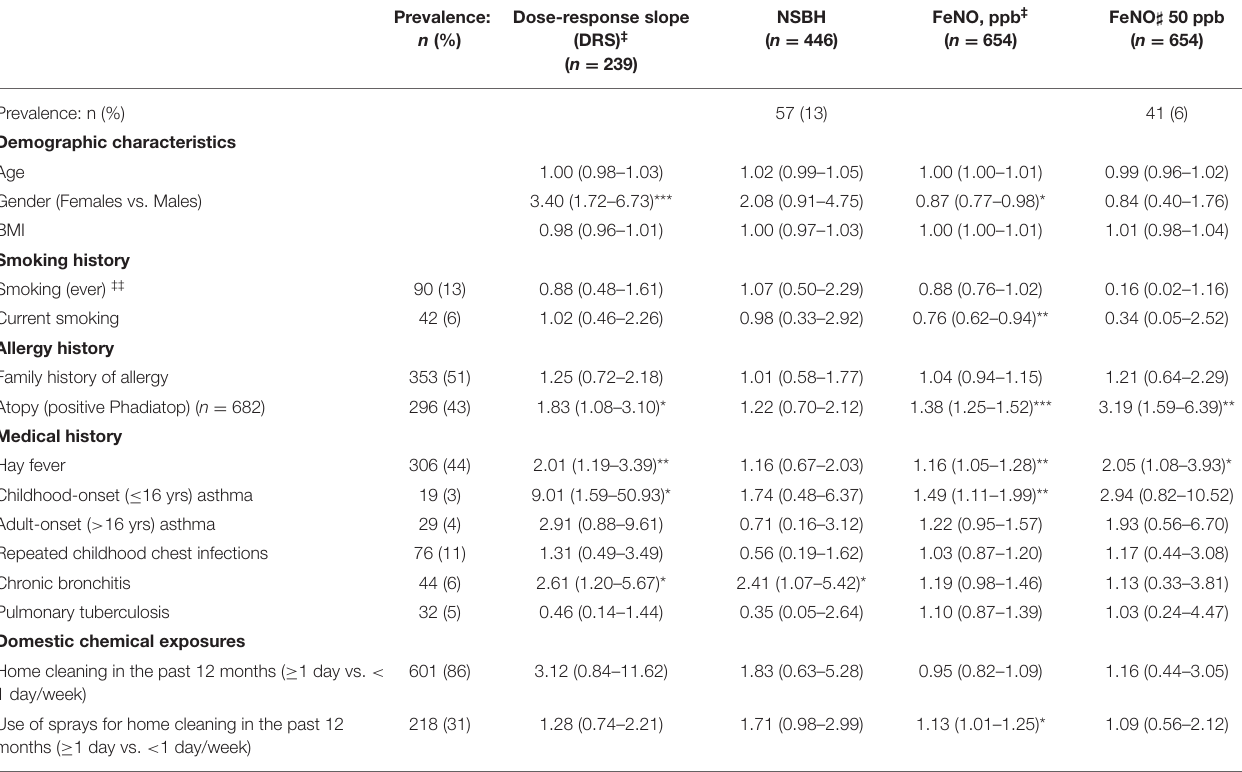
TABLE 6 | Host risk factors associated with bronchial hyperresponsiveness and airway inflammation among health workers working with cleaning